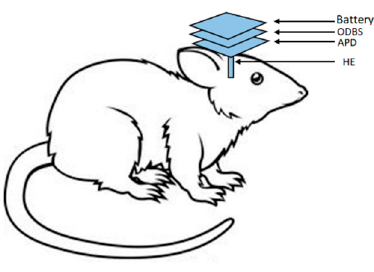
Figure 2. Head-mountable configuration.